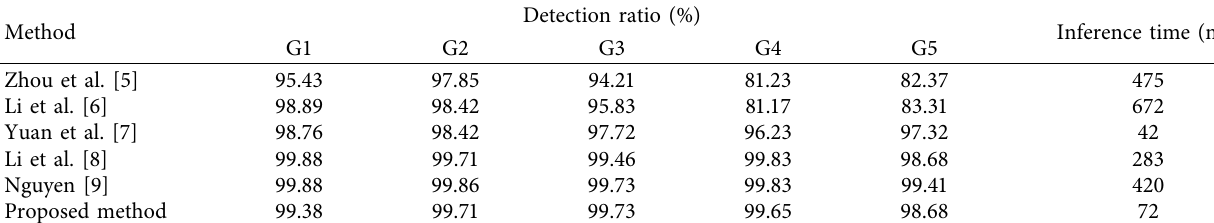
Table 5: Detection results on the PKU vehicle dataset.